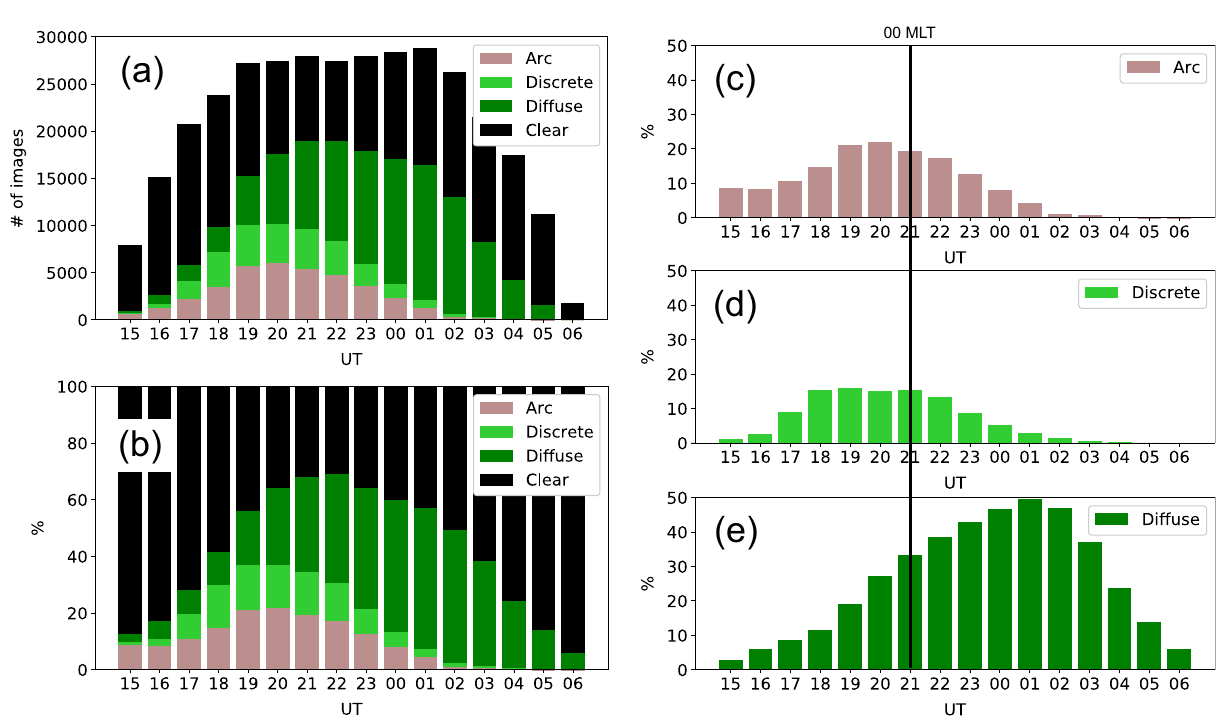
Figure 7. ( a ) Histogram showing the composition of images of Observable classes obtained over 10 years. A decrease in the number of images in 15–18 UT and 03–06 UT is due to the difference in the the length of the dark time. ( b ) The composition ratio of the number of images in the Observable classes. The occurrence rate of aurora was maximum at 22 UT (01 MLT). ( c )–( e ) Composition ratios of panel ( b ) for each Auroral class. The occurrence rate of discrete auroras ( Arc and Discrete ) peaked before 00 MLT and was almost zero after 01 UT (04 MLT). Diffuse was most likely to occur at 01 UT (04 MLT) and the occurrence rate was widely distributed across other